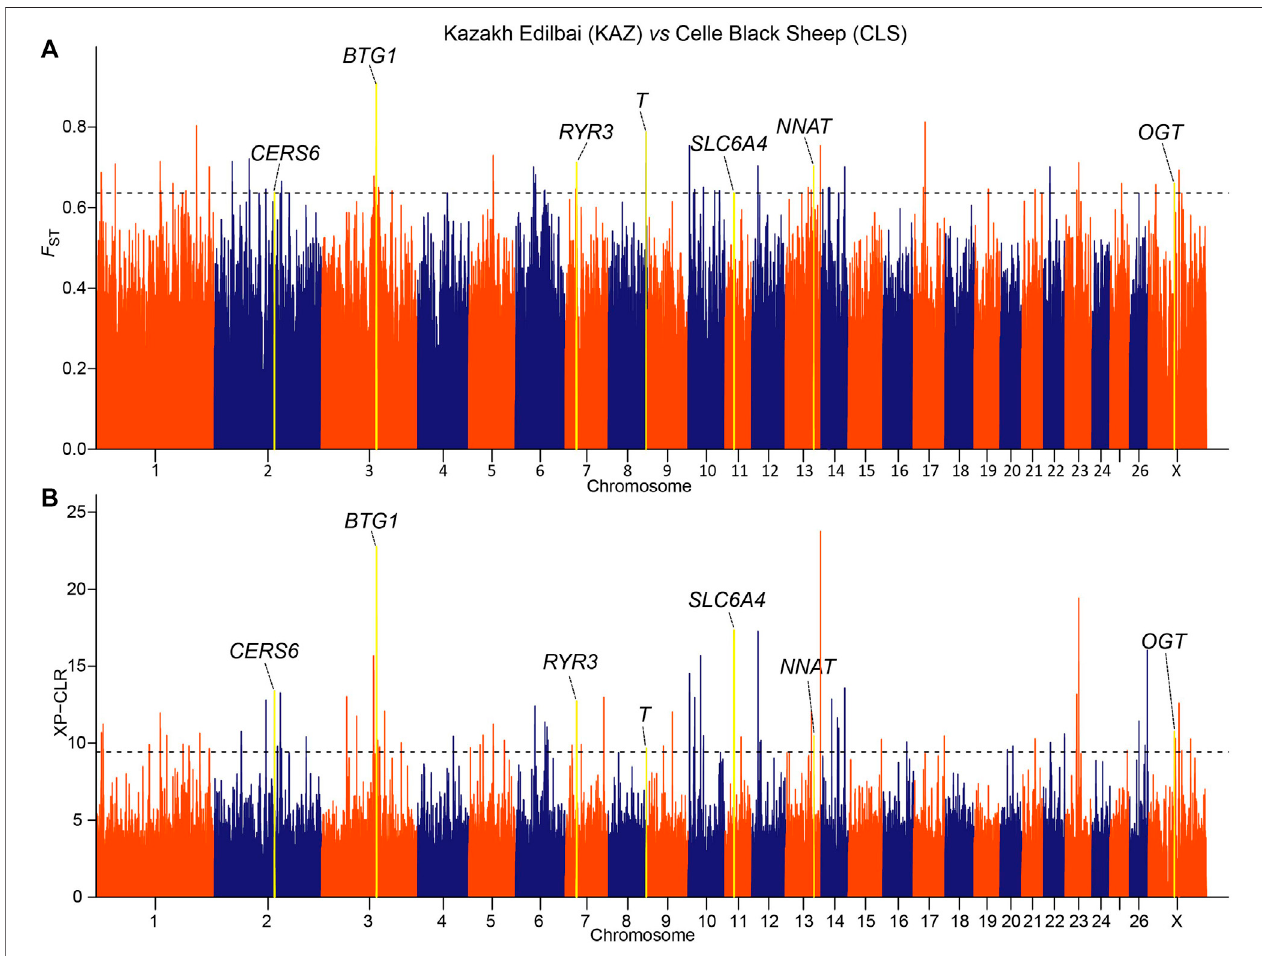
FIGURE 2 | Manhattan plots of (A) pairwise F ST and (B) XP-CLR selection tests with tail shapes in the comparison of Kazakh Edilbai (KAZ) and Celle Black Sheep (CLS) populations. The top 0.02% of the empirical distribution of F ST and 0.05% of the XP-CLR scores are indicated by dotted lines, respectively.